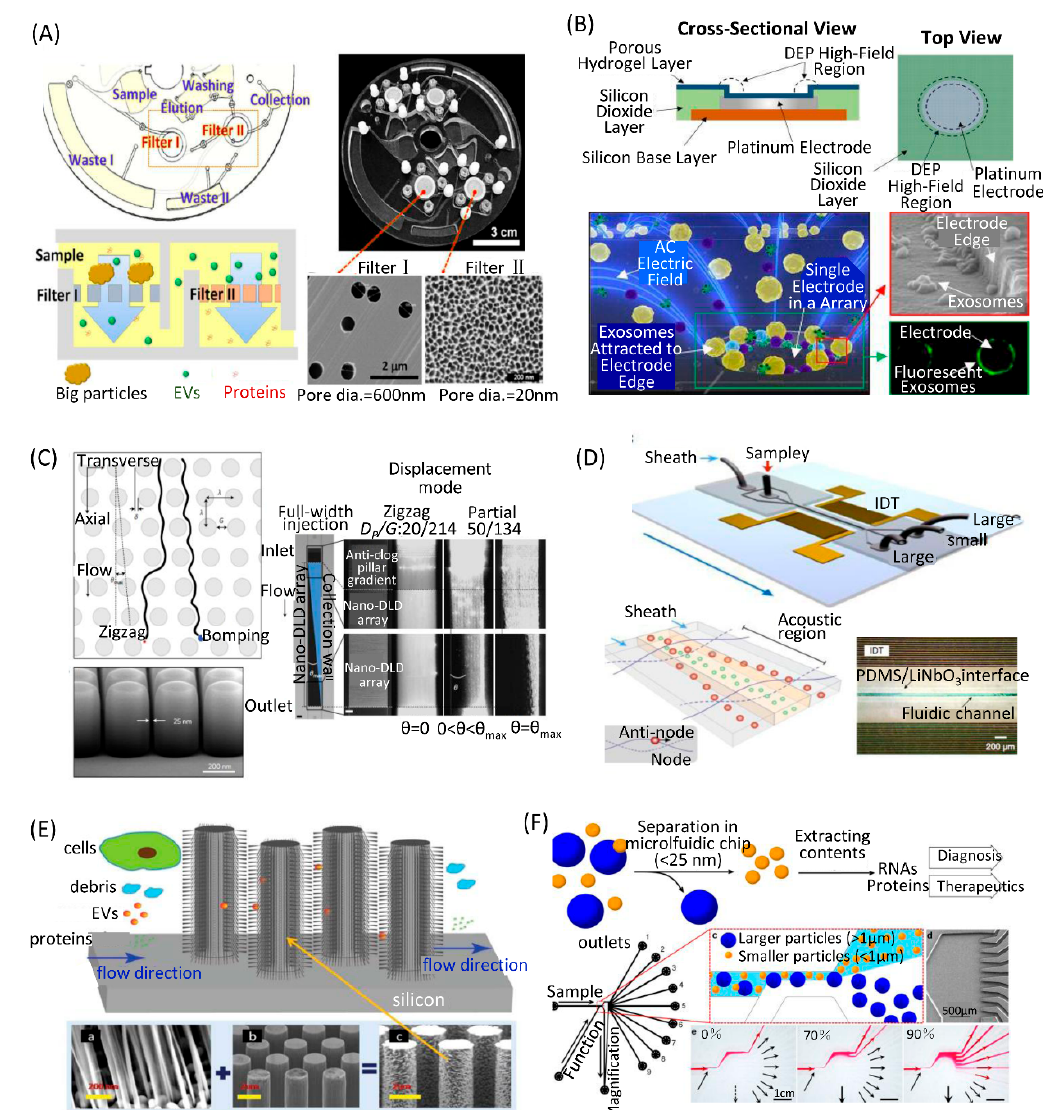
Figure 4. Size-dependent separation EV on microfluidic chips. ( A ) A lab-on-a-disc integrated